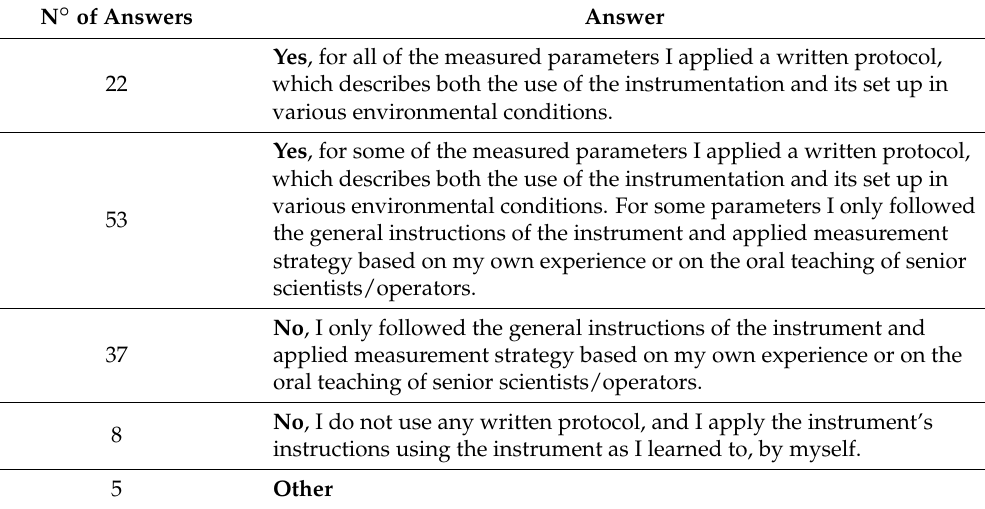
Table 1. Optional answers available to the question “Did you apply a written protocol (published or unpublished, written in any language) when measuring the snow parameters?”, and the number of given answers per